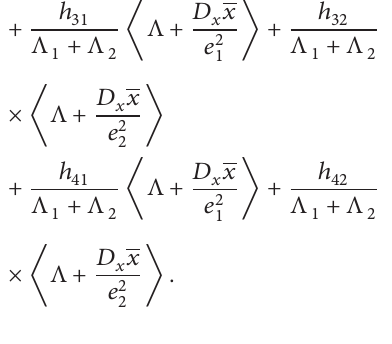
Figure 7: Trajectories of latently infected individuals of (1) for different initial conditions when 𝛽 1 = 2.082 and 𝛽 2 = 2.173 (such that = 3.1492 and 𝑅 2 = 4.1085 ). The endemic equilibrium is locally and asymptotically stable when 𝑅 𝑅 1 0 0 All other parameters are as in Table